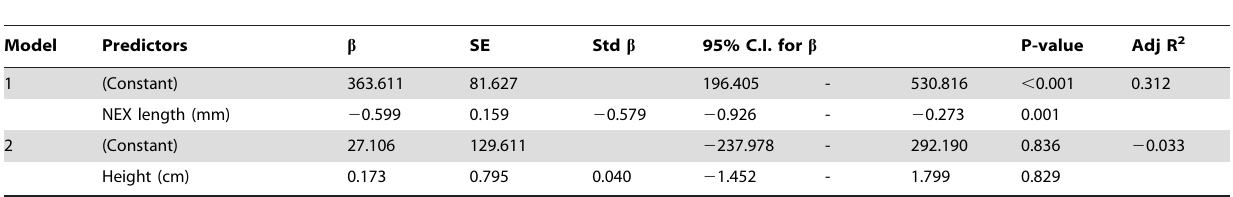
Table 3. Linear regression models on the additional length to secure side-hole placement.